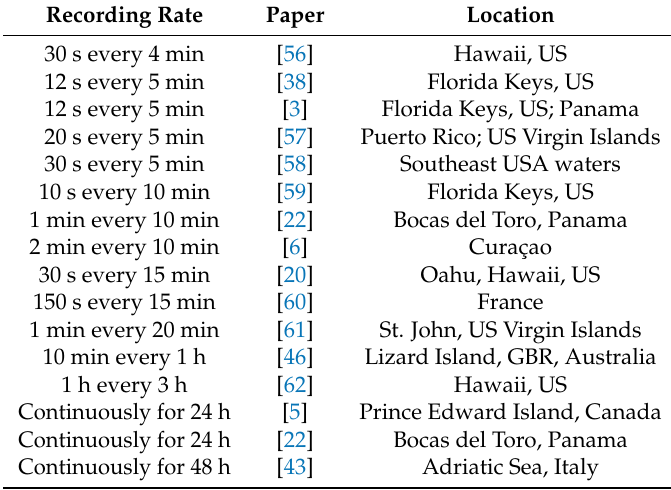
Table 1. Recording rates used in various underwater soundscape ecology and/or long-term passive acoustic monitoring (PAM) studies. GBR: Great Barrier Reef, US: United States.